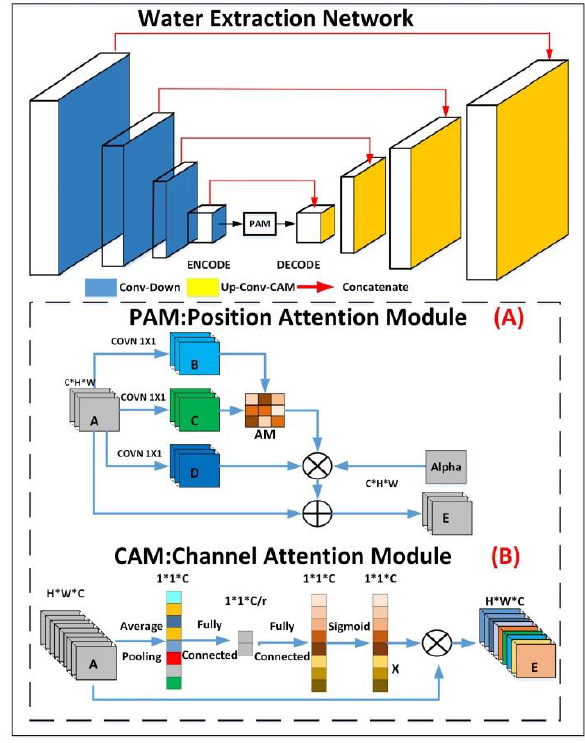
Figure 2. The proposed water extraction